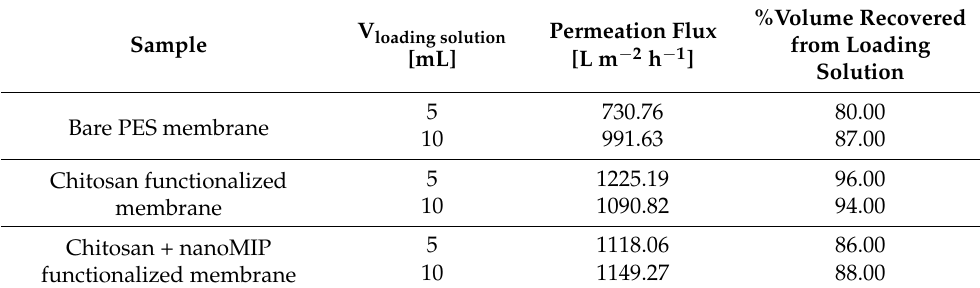
Table 3. Permeation flux